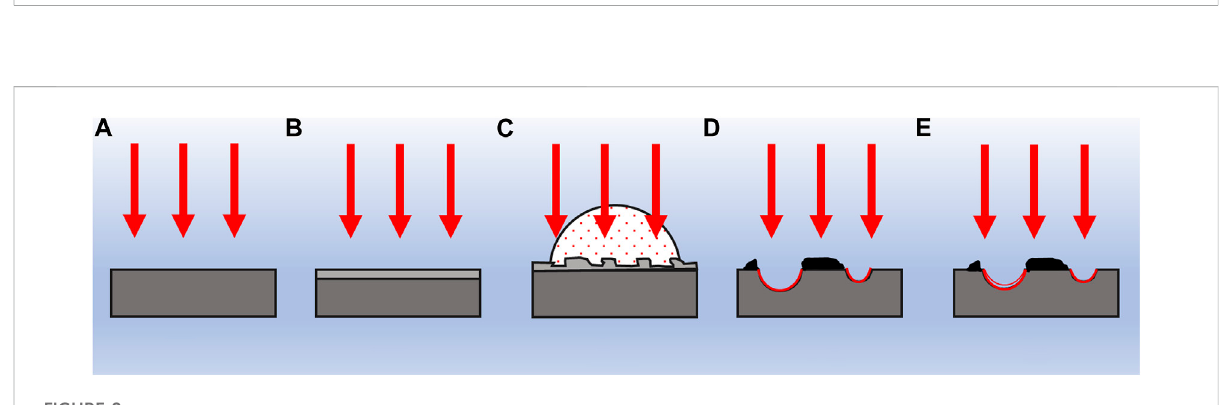
FIGURE 8 Schematic representation showing the stages of laser-induced crater formation: (A) surface absorption and thermal conduction; (B) surface melting (boiling); (C) plasma expansion and shock waves; (D) cavitation bubble generation; and (E) bubble oscillation and crater formation (Guan et al.,